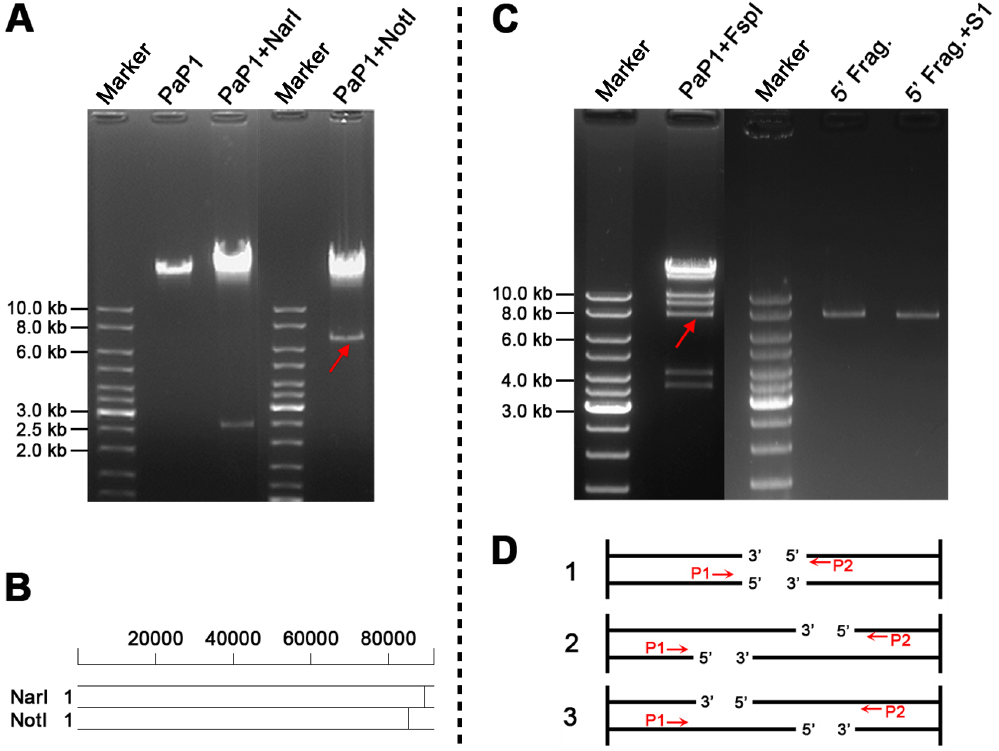
Figure 4. Identification of PaP1 genome ends. (A) Digestion of the PaP1 genome DNA by NarI and NotI. The red arrow indicates the 3 9 end fragment of the PaP1 genome. (B) NarI and NotI restriction map of the PaP1 genome. (C) PaP1 DNA was digested by FspI and the recovered 5 9 end fragment (5 9 Frag., indicated by the red arrow) was digested by S1 nuclease. (D) Strategy designed to identify PaP1 genome ends. Primers P1 and P2 are annealed to 3 9 and 5 9 end fragments of the PaP1 genome DNA, respectively. Terminal run-off sequencing of the two ends (also shown in Figure 5C) is then performed. Case 1 (blunt end): The two sequences obtained by P1 and P2 do not have repeated regions and they can be assembled to the PaP1 genome sequence with no gap between them. Case 2 (3 9 -protruded end): The two sequences obtained by P1 and P2 also do not have repeated regions; however, a gap is observed between the sequences once assembled to the PaP1 genome sequence. The sequence within the gap is the 3 9 -protruded cohesive sequence. Case 3 (5 9 -protruded end or terminal redundancy): A repeat between the two obtained sequences is observed. If the repeated sequence is less than 100 bp, it is regarded as the 5 9 -protruded cohesive sequence [16,19,20]; however, if the repeated sequence is over 100 bp, it is regarded as a terminally redundant sequence